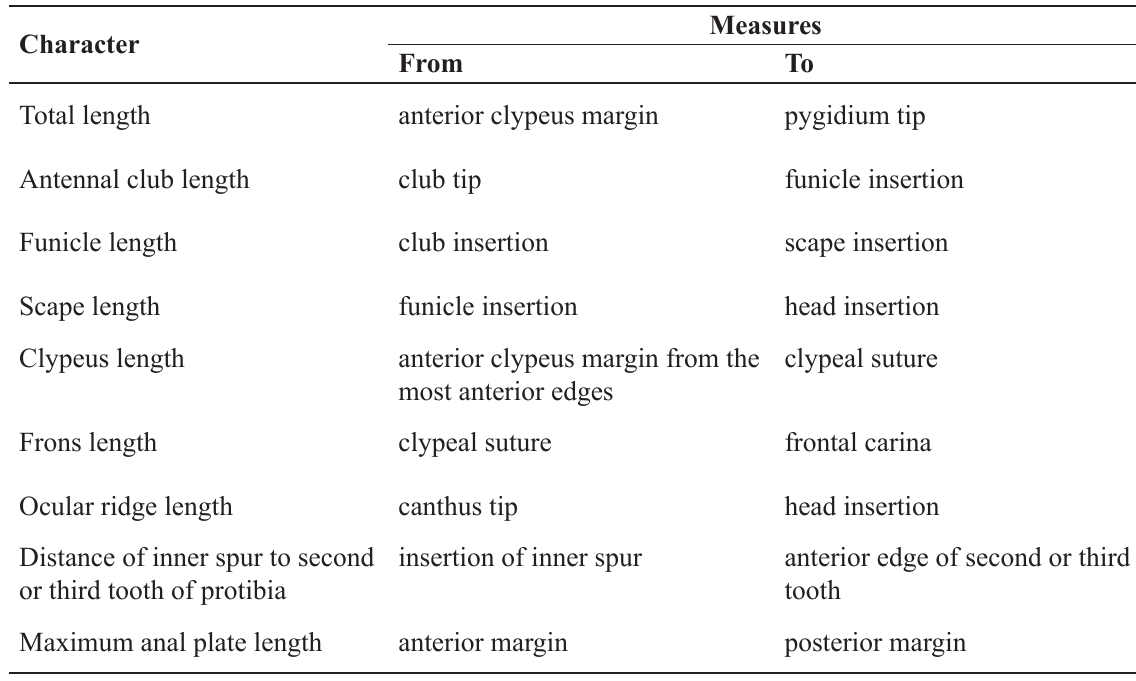
Table 1. Measures of external morphology